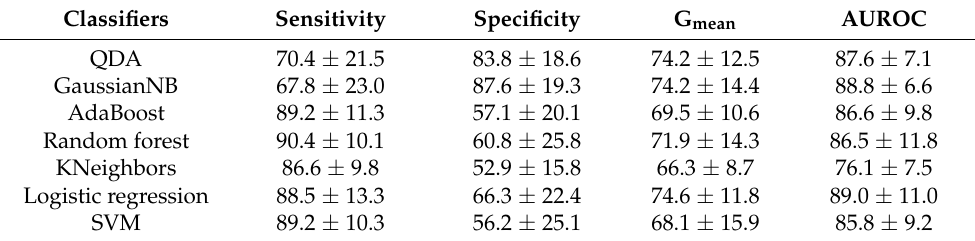
Table 3. Classification metrics ± standard deviation per classifier using GVF feature